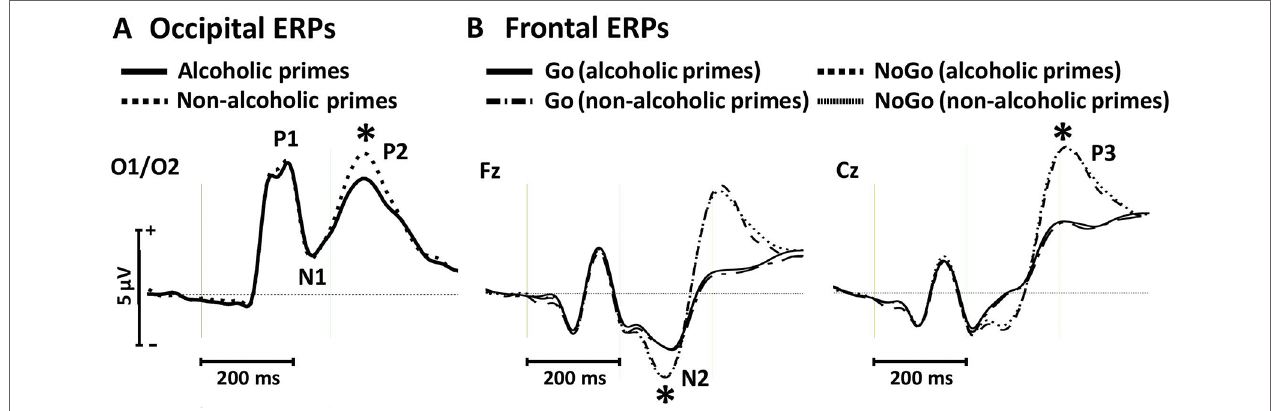
FIGURE 3 | Occipital event-related potentials evoked by alcoholic and nonalcoholic primes (A) and frontal event-related potentials evoked by Go and NoGo targets in the context of alcoholic and nonalcoholic primes (B) in experiment 1. Stars depict significant ( p < 0.05) differences between amplitudes obtained in different